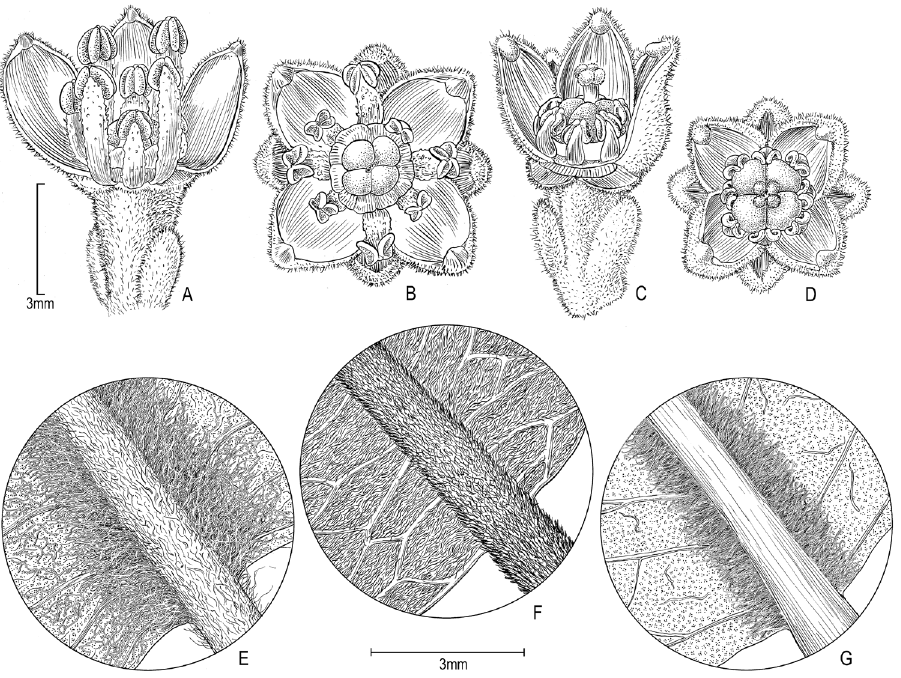
Figure 2. Melicope stonei K.R. Wood, Appelhans & W.L. Wagner. A Male flower, lateral view with sepals and petals cut away to show antisepalous and antipetalous stamens B Male flower, top view C Female flower, lateral view with sepals and petals cut away to show staminodes and pistil D Female flower, top view E–F abaxial leaf surface along midvein of M. stonei showing variability of leaf vestiture G Melicope barbigera A. Gray abaxial leaf surface along midvein A–D from Wood 15101 (PTBG) E from Wagner & Wood 6891 (US) F from Wood 8432 (US) G from Wagner & Wood 6896 (US) (Illustration by Alice